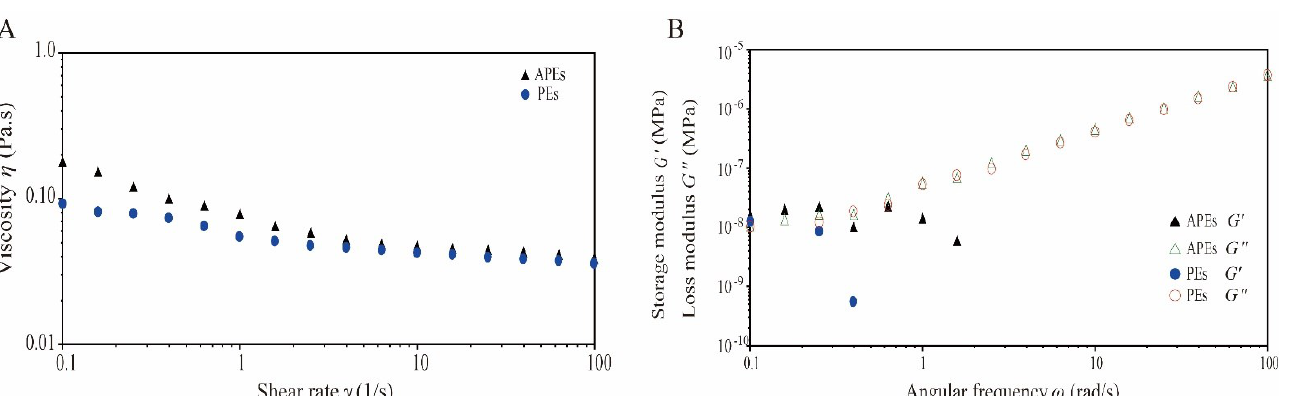
Table 1. Cross model fitting parameters of APEs and PEs at shear rate from 0.1 to 100 (s −1 ) under ambient temperature. Sample